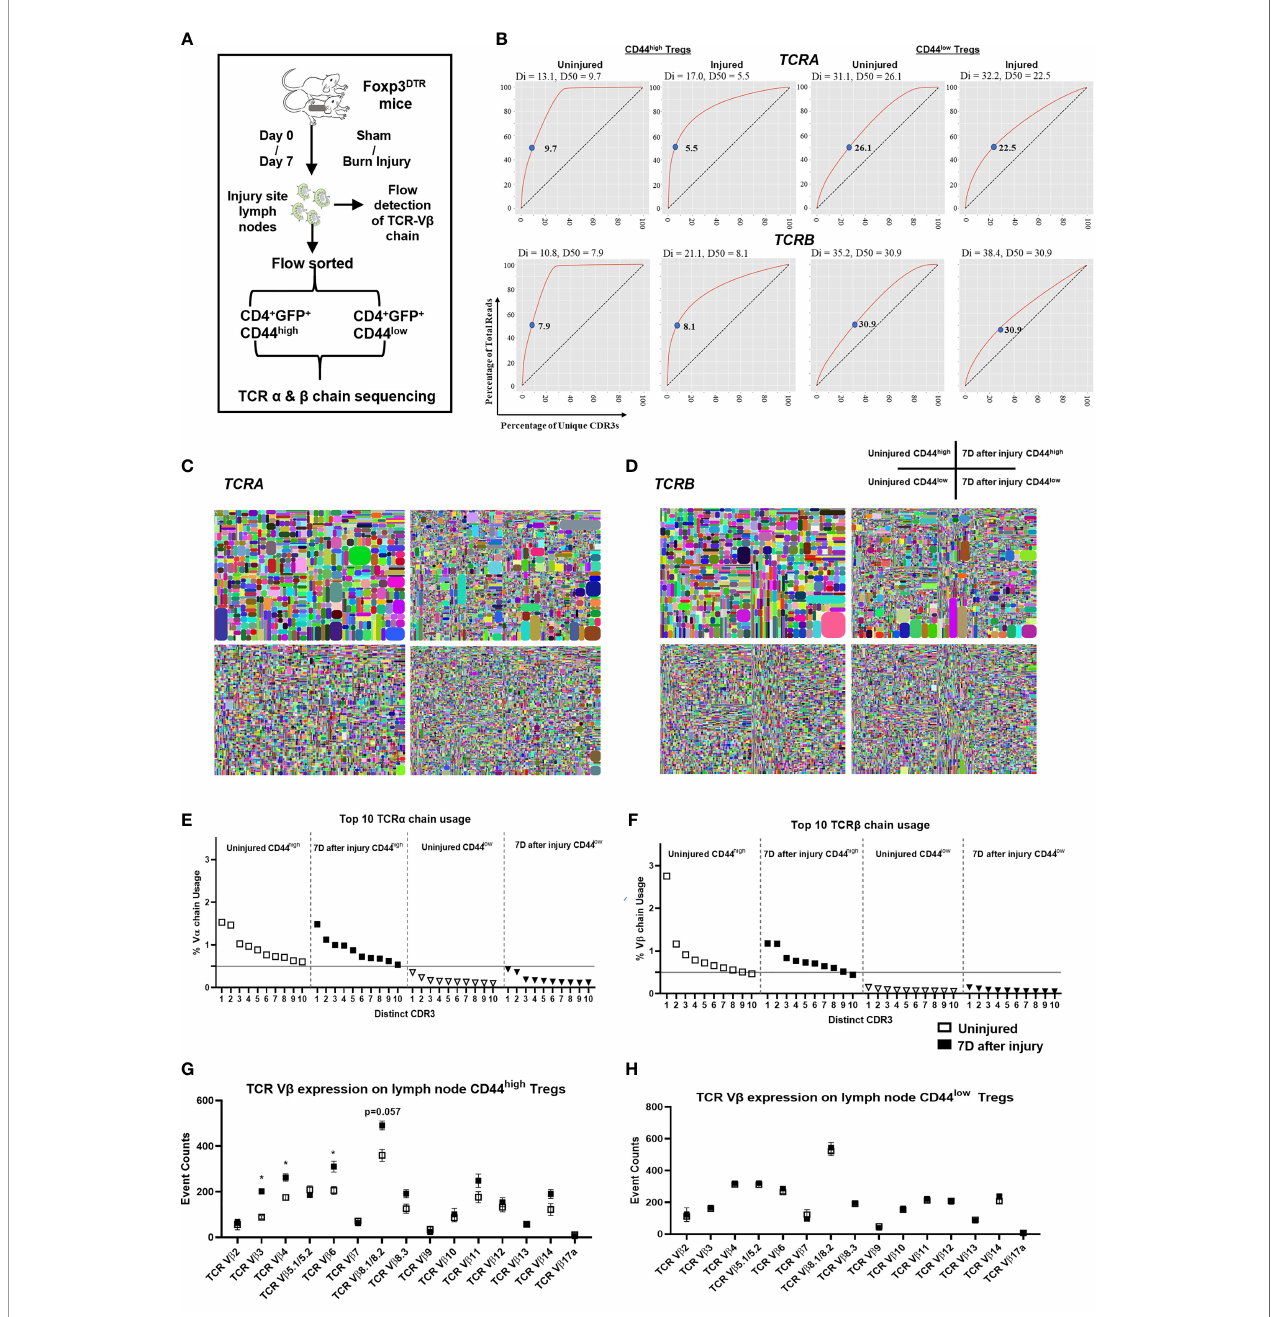
FIGURE 3 | Injury induces greater changes in ab TCR oligoclonality as well as diversity in CD44 high Tregs than in CD44 low Tregs. (A) Experimental scheme of TCR repertoire analysis in injured and uninjured FoxP3 DTR mice. (B) Diversity curves illustrating the diversity of TCRA and TCRB sequences in CD44 high and CD44 low Treg populations from uninjured and injured mice. Curves show the cumulative percentage of total CDR3 sequence reads as a function of the percentage of unique CDR3 sequences. Curves further from the dashed line diagonal have higher clonality. D50 values (blue dots) indicate the percentage of unique CDR3 sequences that account for 50% of the total CDR3 sequence reads. Di values are shown above each graph. Treemap plots of TCR a (C) and TCR b (D) sequencing analysis to illustrate TCR clonotype events from TCR RNA sequencing analysis. Each TCR clonotype is represented by a colored shape and the size of the shape re fl ects the frequency of each CDR3 clonotype variant. Smaller shapes and more varied colors equate to greater diversity in TCR clonality. Top 10 TCR-V a usage (E) and TCR- V b usage (F) among CD44 high and CD44 low Tregs. Flow cytometry analysis of TCR-V b chain expression on (G) CD44 high and (H) CD44 low Tregs using 14 TCR-V b speci fi c antibodies. Bars represent the mean ± SEM. Data were analyzed non-parametric by multiple Mann-Whitney test and are denoted by *P<0.05 or P value compared to injured control. Data represents 3 independent experiments (n=4 mice per